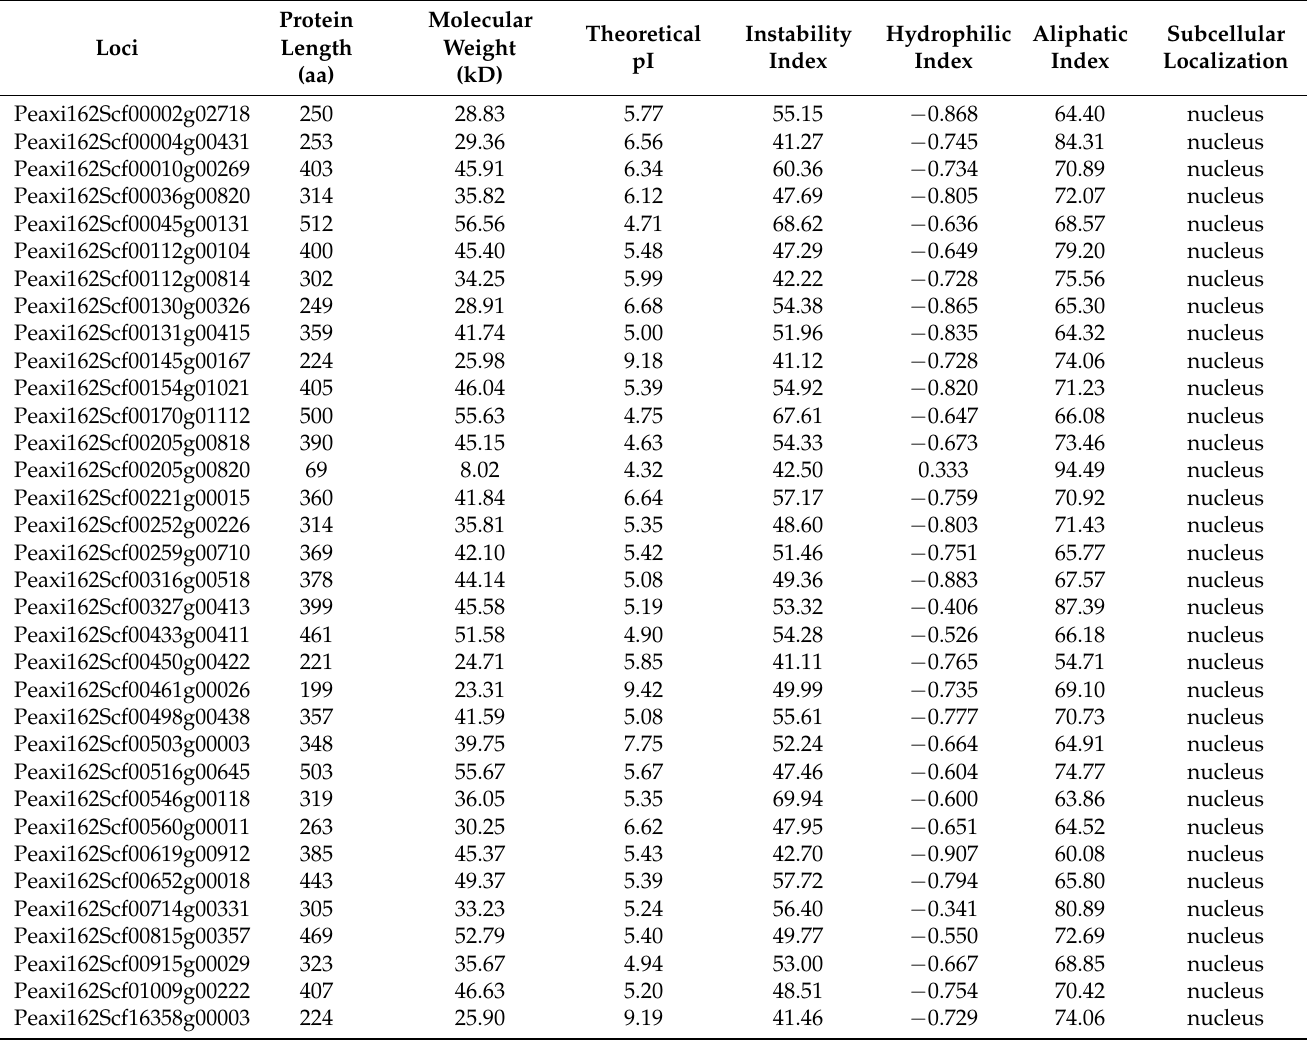
Table 1. Characteristics of petunia heat shock transcription factors, i.e., protein length (aa), molecular weight (MW), theoretical isoelectric point (pI), instability index, hydrophilic index, aliphatic index, and predicted subcellular